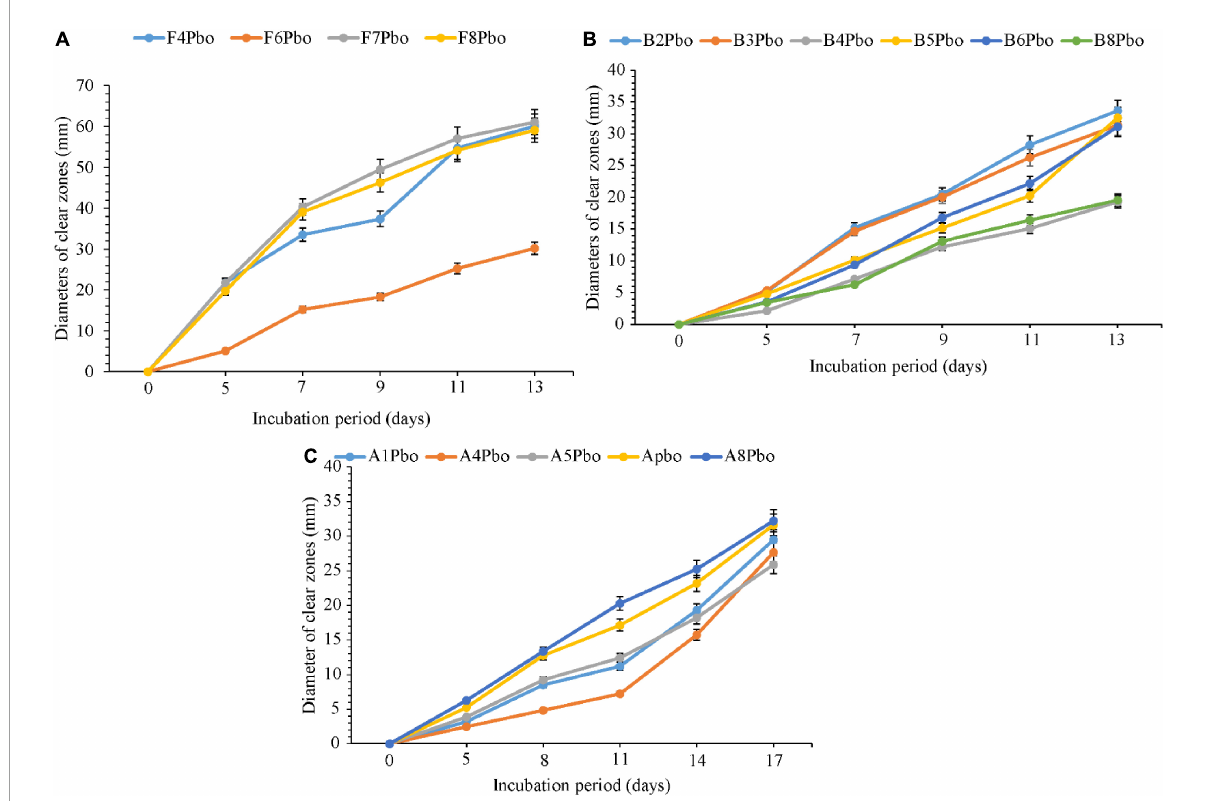
FIGURE4 Comparative ability of the (A) fungi, (B) bacteria, and (C) actinomycetes in degrading ground plastic bottles. Error bars represent the mean ± SD of three independent biological replicates (the names of species coded with letters F represents fungi, B represents bacteria, and A represents actinomycetes, and the numbers represent their positions in a particular group as shown in Table 6